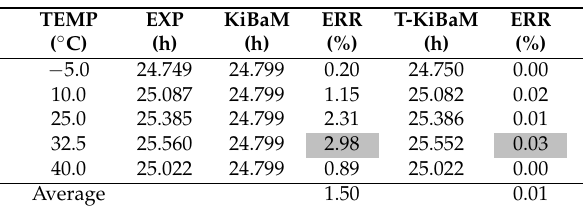
Table 8. Comparison between